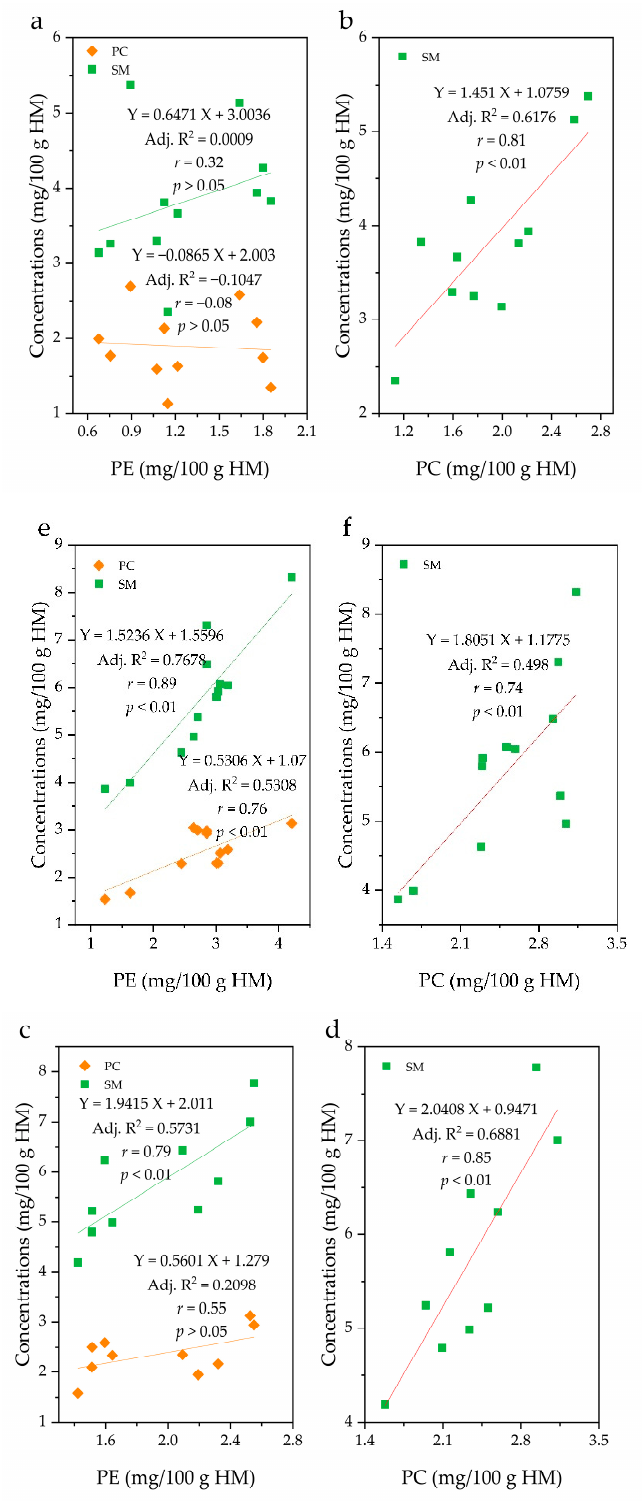
Figure 6. Correlations between the concentrations of phospholipid species in human milk (HM). A group = a and b ( n = 11); B group = c and d ( n = 10, one sample in group B was omitted due to insufficient amount for analysis); C group = e and f ( n = 12). PE, phosphatidylethanolamine; PC, phosphatidylcholine; SM, sphingomyelin.